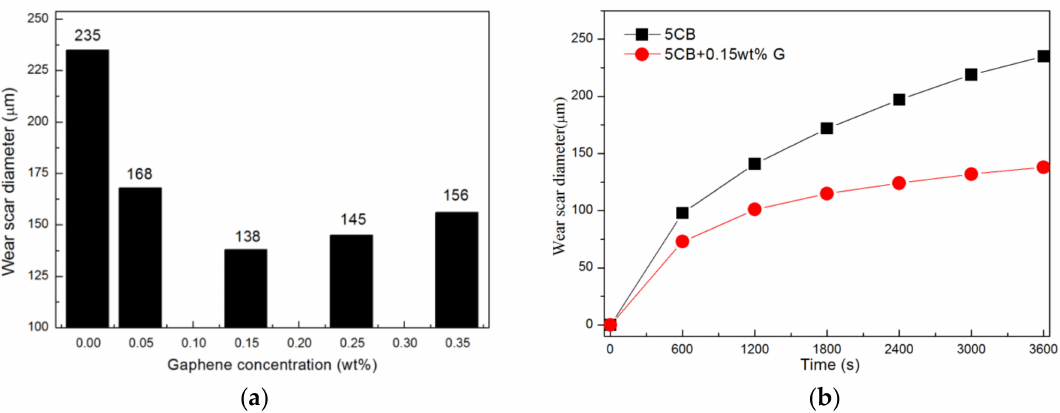
Figure 3. ( a ) The average wear scar diameter at various graphene concentrations after friction tests. ( b ) The average wear scar diameter of 5CB and 5CB+0.15 wt.% G lubricants at different times during friction